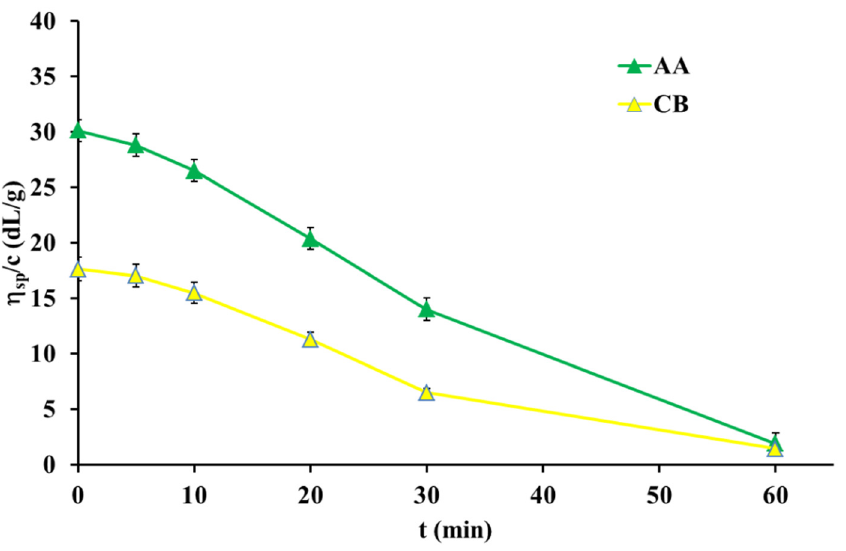
Figure 3. Plots of reduced viscosity vs. times of UV irradiation for 0.5 mg/mL collagen solutions.